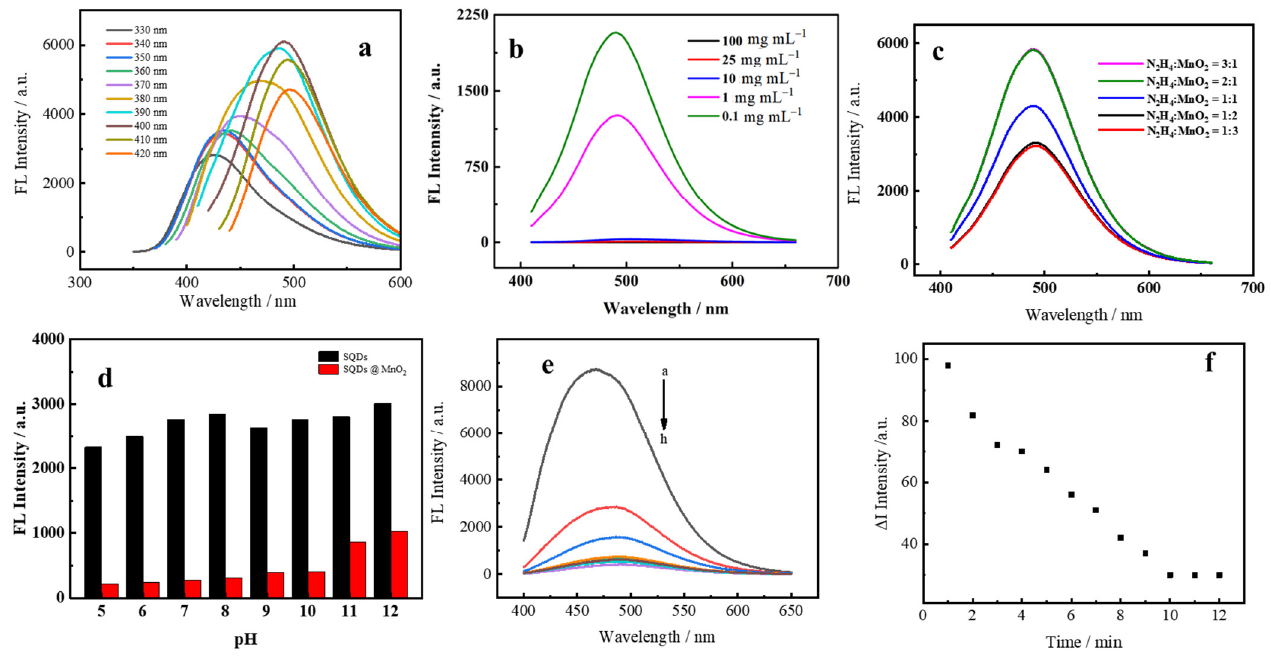
Figure 5. Optimization of conditions: ( a ) optimal excitation wavelength for SQDs; ( b ) concentrations of MnO 2 NS; ( c ) volume ratio of N 2 H 4 to MnO 2 NS; ( d ) Different pH; ( e ) the molar ratio of SQDs@MnO 2 (a–h (SQDs: MnO 2 = 10:0, 10:1, 10:2, 10:3, 10:4, 10:5, 10:6, 10:7)); ( f ) the response time of SQDs@MnO 2 with N 2 H 4 .